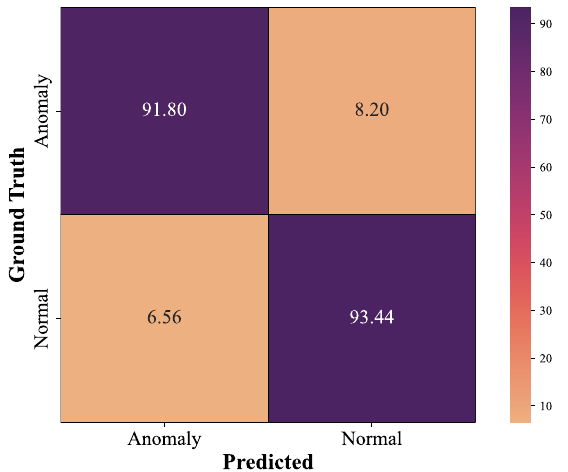
Figure 5. The confusion matrix for the proposed model (CNN-LSTM-Attention-Leaky ReLU) on the augmented dataset.